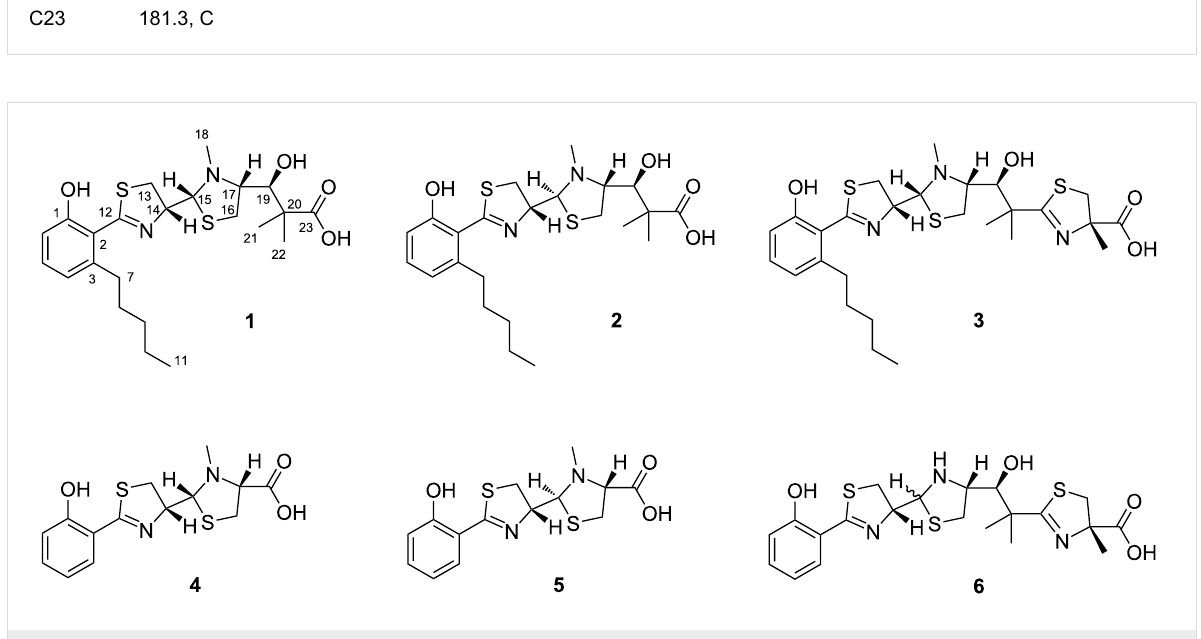
Figure 2: Structures of massiliachelin ( 1 ), agrochelin ( 2 ), micacocidin ( 3 ), pyochelin I ( 4 ), pyochelin II ( 5 ), and yersiniabactin ( 6 ).